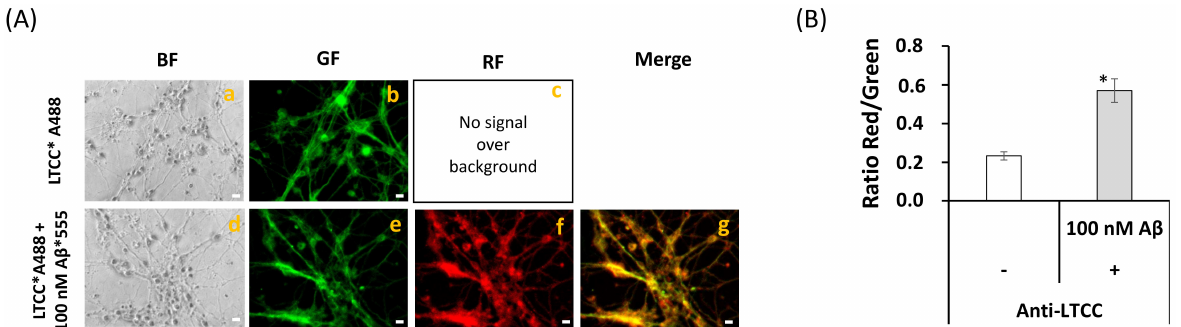
Figure 8. Extensive FRET between LTTC and A β (1–42) . ( A ) Representative quantitative fluorescence microscopy images of CGN stained with the anti-LTCC subunit α 1C (sc-25686)/IgG-Alexa488 antibodies (LTCC*A488, a–c) or with anti- LTCC/IgG-Alexa488 and A β (1–42) HiLyte TM Fluor 555 (LTCC*A488/A β (1–42), d–g). Bright-field (BF), green fluorescence (GF), and red fluorescence (RF) images are shown for each of the selected fields, and the orange-yellow areas (Merge image) pointed out the higher intensity FRET regions (g). The exposure time for GF and RF images was 0.4 s. Scale bar inserted in fluorescence microscopy images = 10 µ m. ( B ) Ratio of red/green fluorescence intensity per pixel (RF/GF) obtained from the analysis of fluorescence intensity data of CGN somas stained with anti-LTCC/IgG-Alexa488 only (LTCC*A488) and double stained with anti-LTCC*IgG-Alexa488/A β (1–42) HiLyte TM Fluor 555 (LTCC*A488/A β (1–42)). The results shown in ( B ) are the mean ± s.e. (*) p < 0.05 (i.e., statistically significant with respect to the control, CGN labeled with the Alexa488 FRET donor